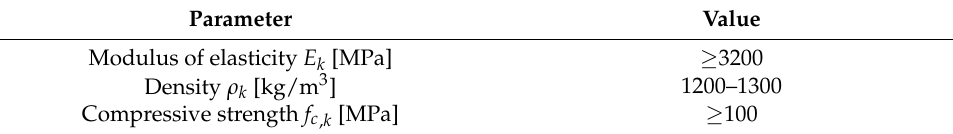
Table 3. Technical data of epoxy resin (exposed by manufacturer)